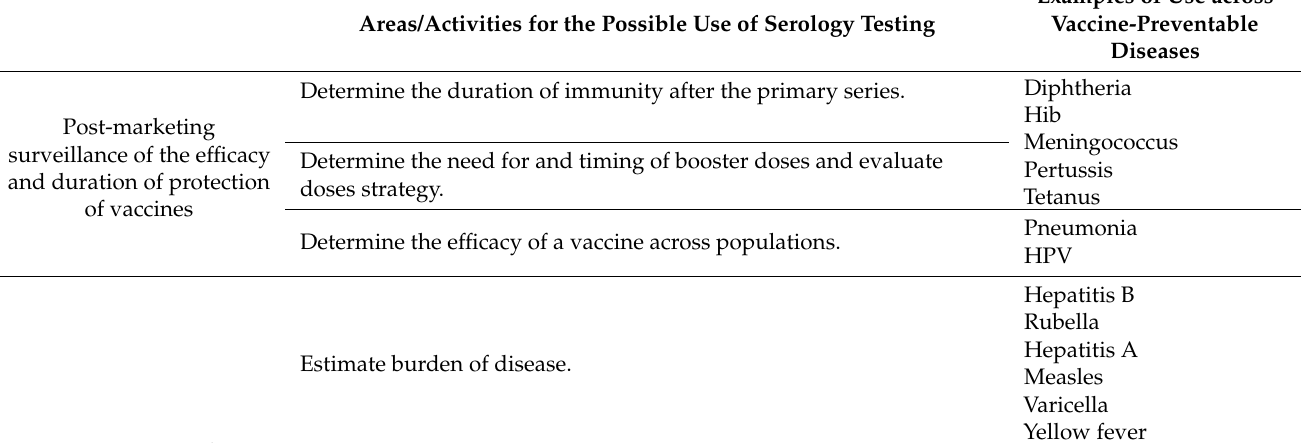
Areas/Activities for the Possible Use of Serology